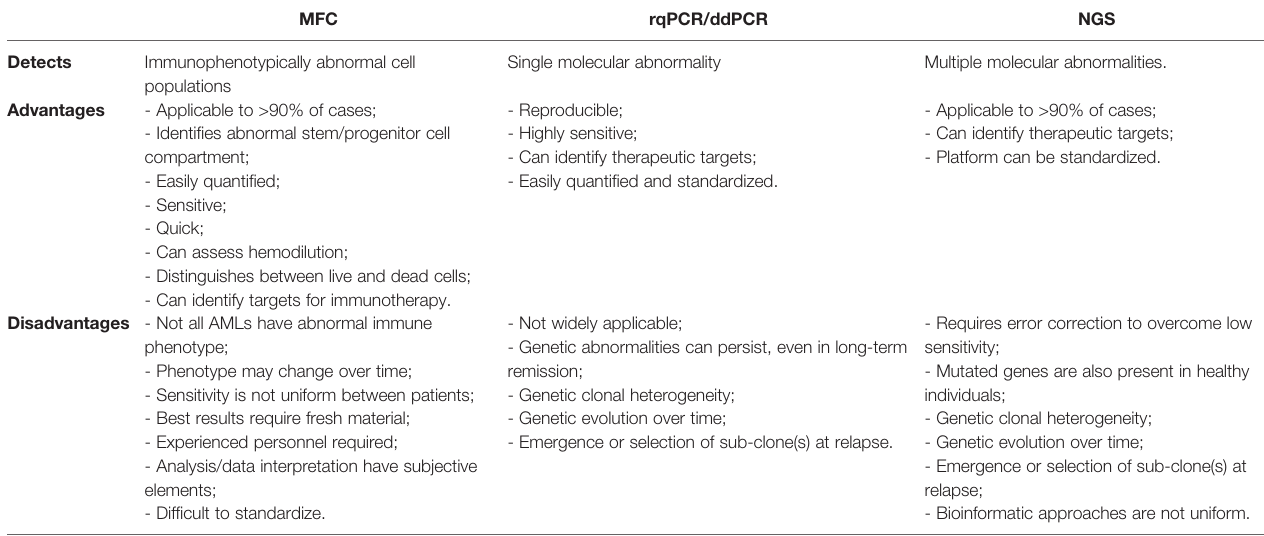
Table reproduced from Walter R., oral presentation